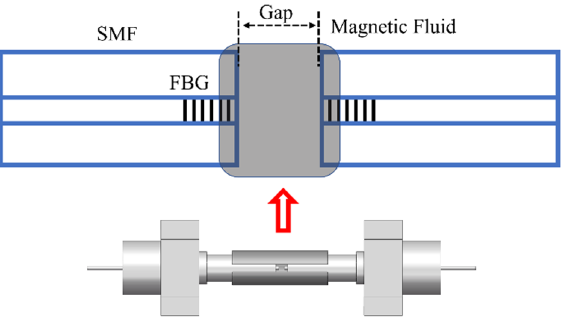
Figure 6. The schematic diagram of the magnetic fluid-infiltrated PS-FBG.